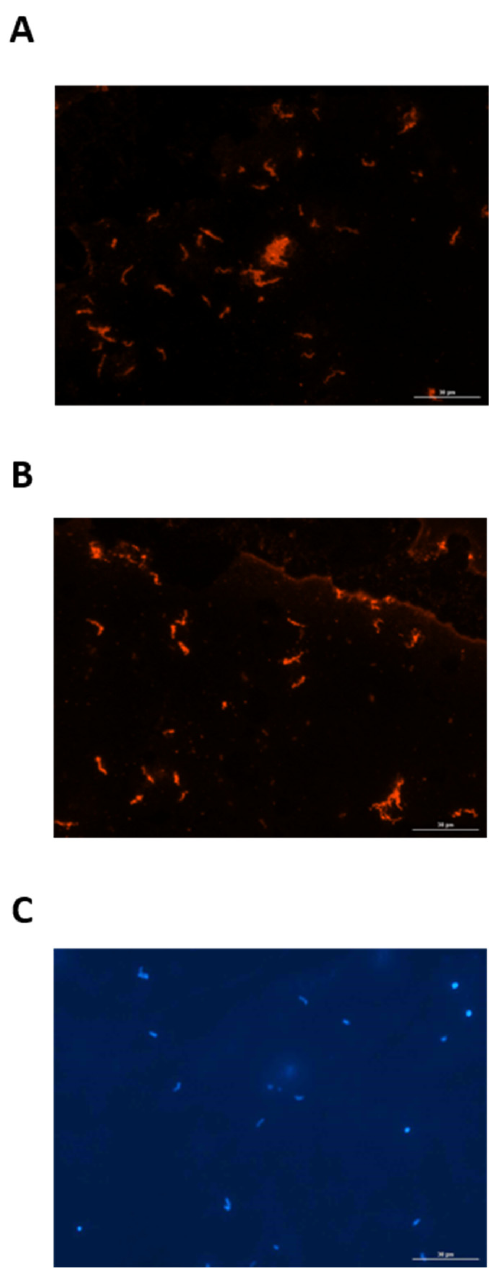
Figure 3. Representative fluorescent antibody test demonstrating that urinary-derived leptospires are reactive with ( A ) serum and ( B ) urine from experimentally infected rats. Urinary-derived leptospires are not reactive when probed directly with anti-IgG. The presence of leptospires in all samples tested was confirmed by DAPI ( C ). Original magnification ×400.